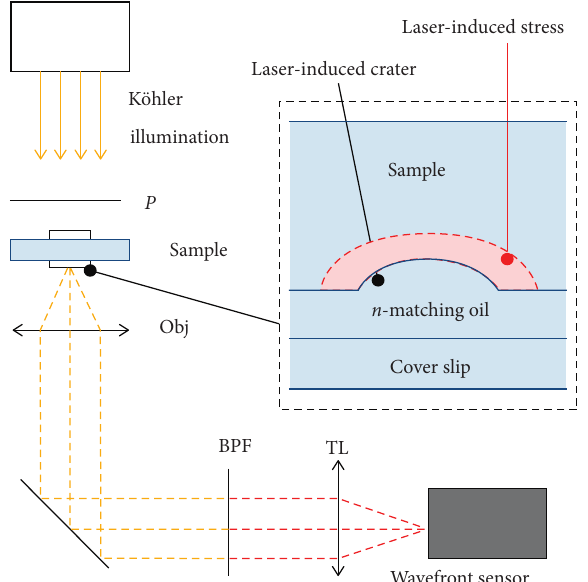
Figure 1: Experimental configuration. P: polarizer; Obj.: micro- scope objective; BPF: bandpass filter; TL: tube lens Figure 3. In this experiment, a light-emitting diode light source with a wavelength of 520 nm is used. The glass is fixed on the stage and placed parallel to the X-Y plane. The high- speed polarization camera is placed along the normal di- rection of the glass sample. The circularly polarized light is obtained through a polarizer and a quarter-wave plate and focused on the glass. The laser beam is scanned along the X-axis; meanwhile, the sample moves along the X-axis through the electric stage. Four polarizers with different polarization axes are set on the camera to obtain the images on each polarization axis. In fact, the birefringence retar- dation and azimuth angle are observed according to the images, which are obtained by the polarizing camera, and the results of measurement and calculation are shown in Fig- ure 4. The residual birefringence is close to axisymmetric, and there is a slight difference between the experimental results and the numerical results of birefringence retarda- tion, which is due to the deformation of the laser spot in the experimental process. The azimuthal angle is measured through a polarization camera experiment based on pho- toelastic theoretical analysis to indicate the stress direction.